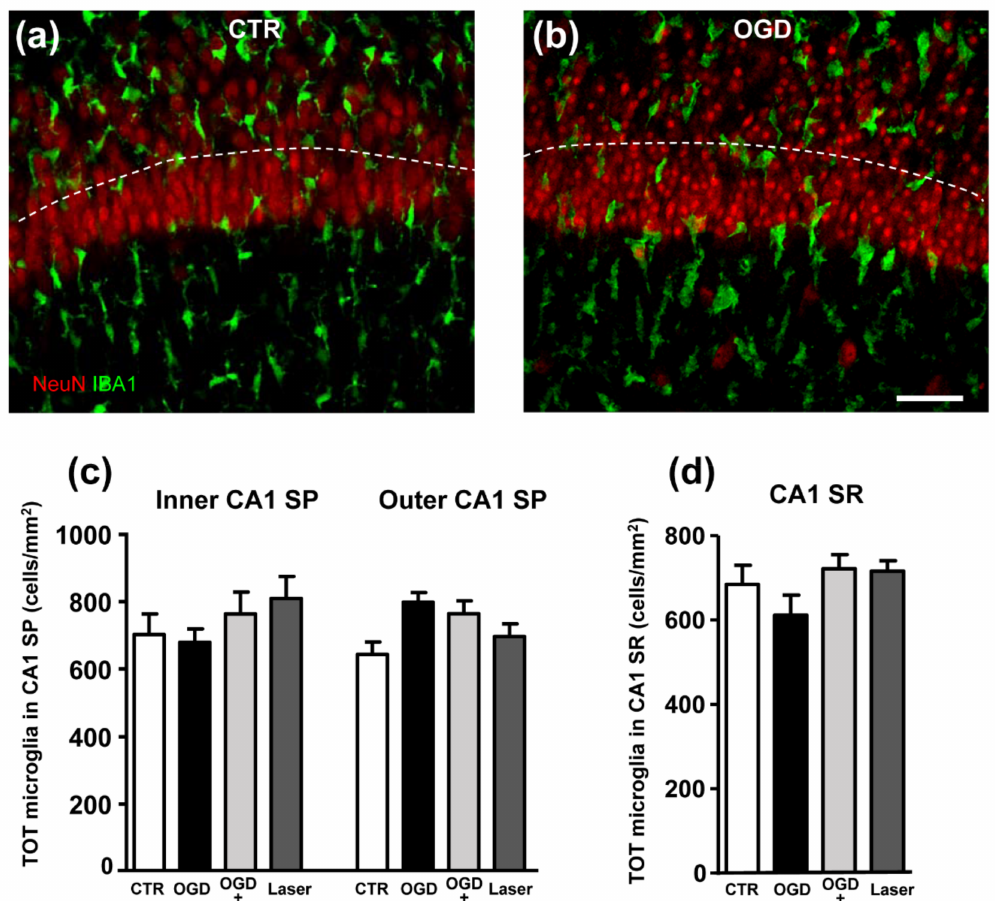
Figure 2. ( a , b ) Representative confocal images of NeuN-positive neurons (red), and IBA1-positive total microglia (green) in CA1 of a CTR ( a ), and an OGD ( b ) organotypic hippocampal slice captured with a 40 × objective. The images were obtained stacking 5 consecutive confocal scans (z step 0.5 µ m, total thickness 2.5 µ m). The dotted lines delineate the inner and outer CA1 SP layers. Scale bar: 20 µ m. ( c ) Quantitative analyses of total microglia density (cells/mm 2 ) in the inner and outer layers of CA1 SP. Statistical analysis: n.s. ( d ) Quantitative analyses of total microglia density (cells/mm 2 ) in CA1 SR. Statistical analysis: n.s. In the bar graphs, each bar represents the mean ± SEM of 6–7 independent slices. All statistical analyses were performed by One-way ANOVA followed by Newman-Keuls post hoc